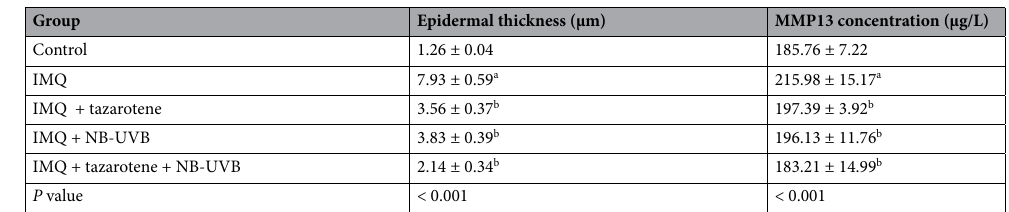
Table 1. Quantification of skin thickness and measurement of serum MMP13 levels in mice after indicated treatments. a P < 0.05 relative to control group. b P < 0.05 relative to IMQ group. Data represent the mean ± standard deviation. The data were analyzed using one-way ANOVA with Dunnett’s multiple test.